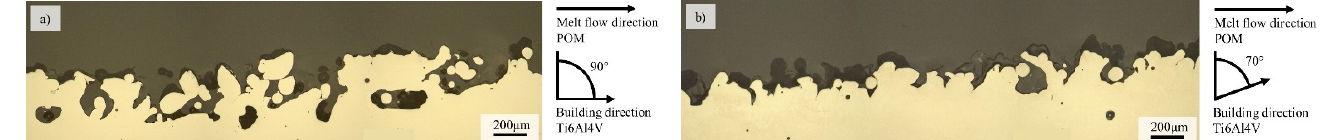
Figure 7. ( a ) Optical micrographs detailing the boundary layer of POM AR10 PTFE10 and the Ti6Al4V insert built at an angle of 90 ◦ . ( b ) Optical micrographs detailing the boundary layer of POM AR10 PTFE10 and the Ti6Al4V insert built at an angle of 70 ◦ .